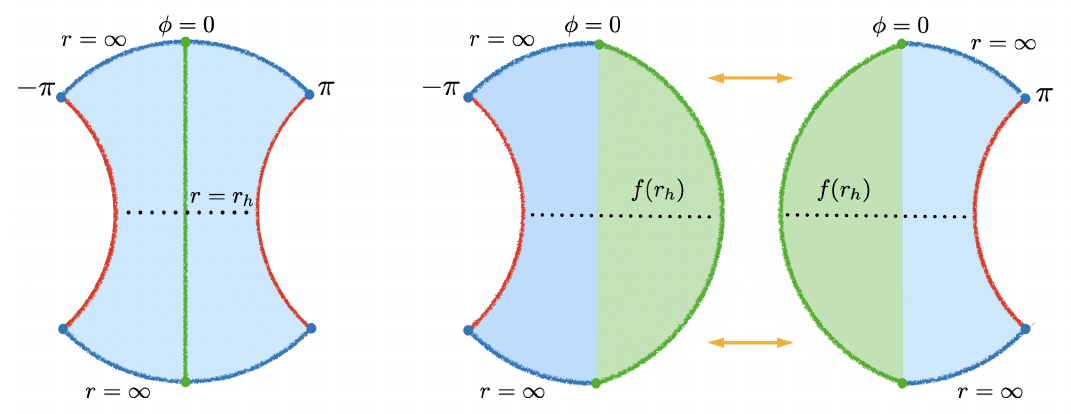
Figure 1 . On the left, a t = 0 time slice of the BTZ spacetime with the brane shown in green, intersecting the two asymptotic boundaries at φ = 0 . The red lines correspond to φ = − π and φ = π and are to be identified. We show the boundaries at r → ∞ in blue at the top and bottom, and the horizon r = r with a dotted line. Recall the backreaction of the brane generates a great h deal of ‘extra’ geometry near the brane. This effect is illustrated in the sketch of the t = 0 slice on the right, where the two regions are glued together along the green curve. The shaded green region corresponds to the extra geometry that the brane